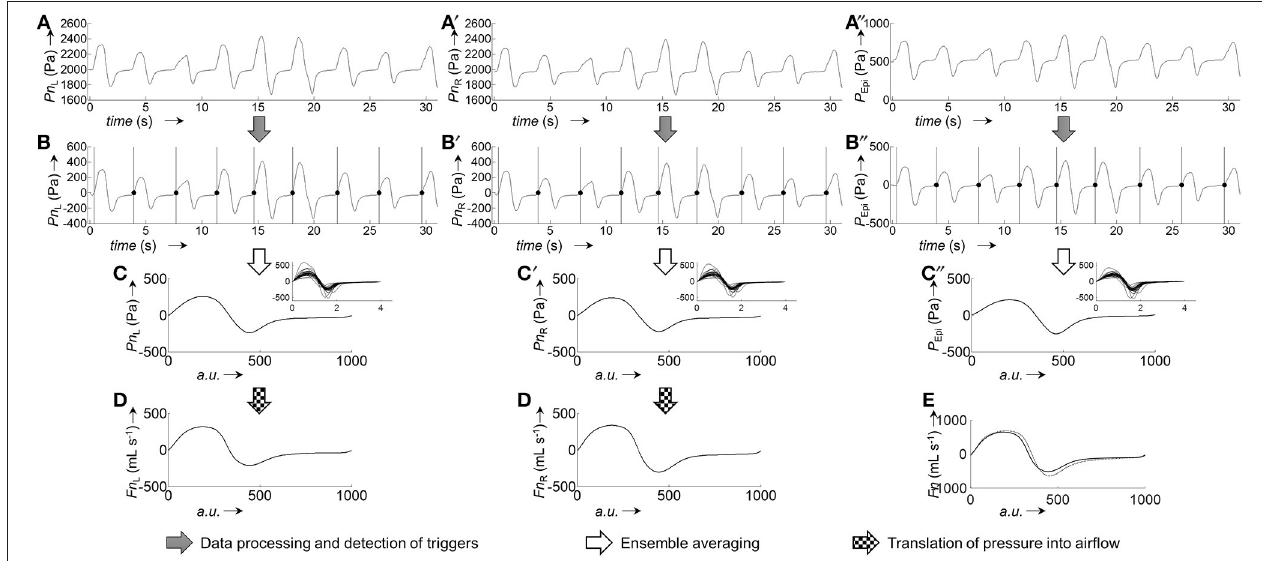
FIGURE 5 | Derivation of ensemble averaged bilateral airflow ( Fn L , Fn R ) and epipharyngeal pressure ( P Epi ) from bilateral pressure recordings ( Pn L , Pn R ) of a representative 2-min segment. Excerpt (first 30s) of raw pressure recordings of a 2-min segment: (A) , left nasal pressure ( Pn L ); (A’) , right nasal pressure ( Pn R ); (A”) , epipharyngeal pressure ( P Epi ). Processed pressure signals (after application of filtering, offset correction, and cross-correlation): (B) , Pn L ; (B’) , Pn R ; (B”) , P Epi ; the vertical bars and black dots indicate the positions at which the signals were cut into the individual breaths (vertical bars: start of breath, dots: end of breath). Ensemble averaged pressure: (C) , Pn L ; (C’) , Pn R ; (C”) , P Epi . The insets show the individual breaths, overlayed on top of each other, from which the ensemble averaged curves were obtained. Pressure-derived airflow: (D) , Fn L , (D’) , Fn R . (E) , Overlay of total derived airflow ( Fn L ( F PNT , dotted line). All ensemble averaged signals were normalized to 1,000 data points.